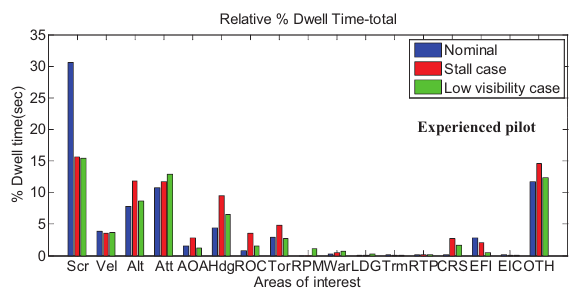
Figure 7. PDT for all three cases